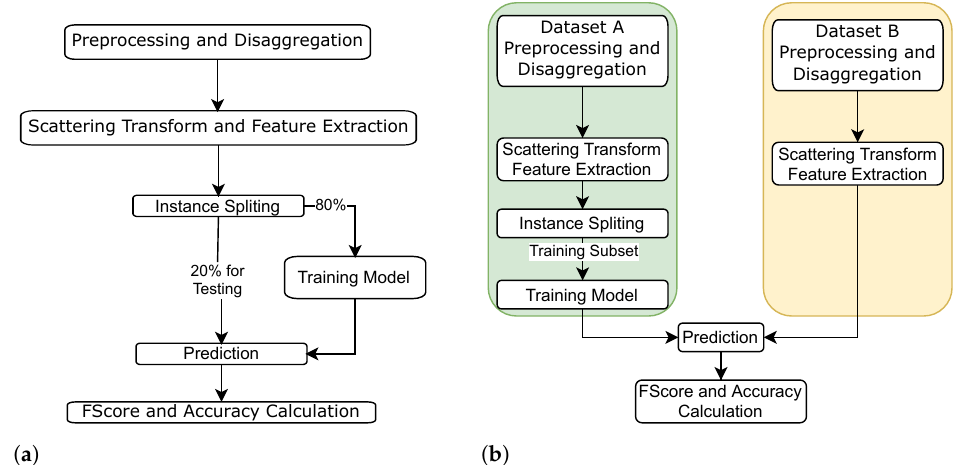
Figure 1. Proposed framework experimental setup. ( a ) With the same datasets. ( b ) With different